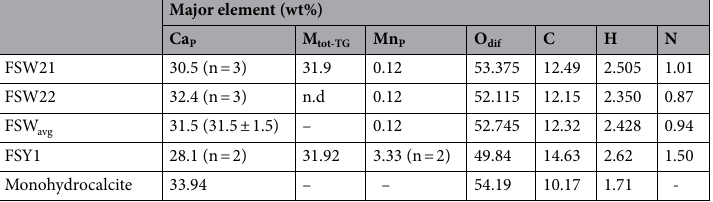
Table 1. Major element compositions (wt%) for two FSW and one FSY HACC samples, and for monohydrocalcite. Additional compositional details are in Tables S1 and S2. P—PIXE. M tot-TG —total metal wt% determined by TG assuming that the product after heating to 1000 °C is (Ca, Mn)O only. O diff —oxygen determined by the difference of the sum of the measured elements. C, H, N by bulk CHN analysis. n.d.—not